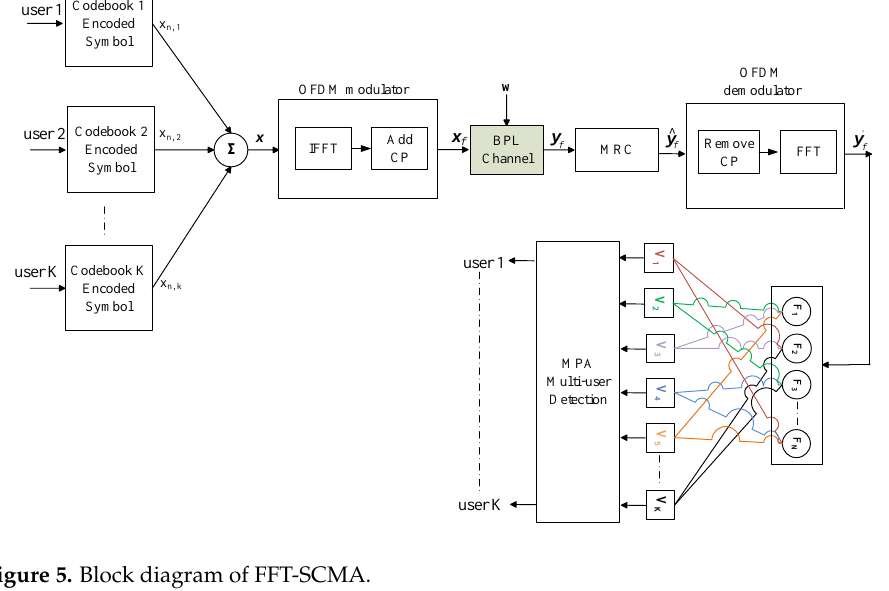
Figure 5. Block diagram of